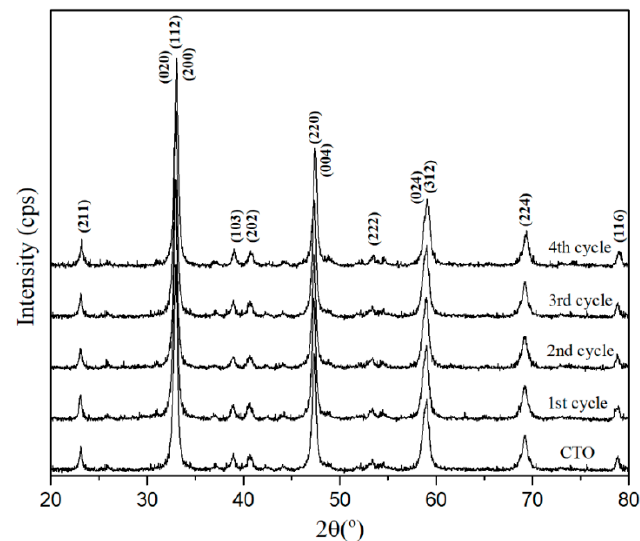
Figure 12. XRD pattern of CTO nanoparticles measured after each cycle of